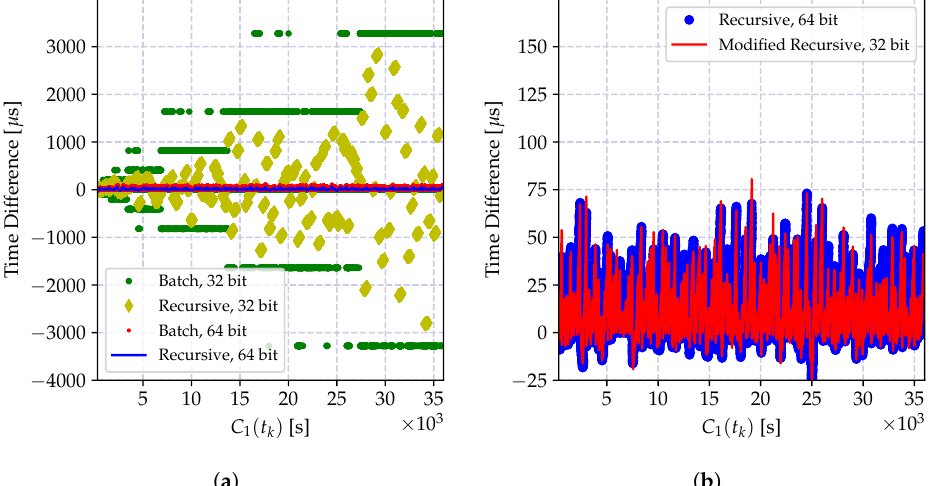
Figure 11. The variation of the time difference in microseconds between the time reports of a local clock and a reference clock with 32-bit and 64-bit floating point numerical precision representation of the quantities when the time relation parameters of the incremental time model are estimated every ∆ = 300 s. In ( a ), the performance of batch linear regression with a regression table of N = 8 entries, and recursive weighted maximum likelihood estimator with weight λ = 0.4. In ( b ), numerically stabilized estimator and 64-bit implementation of the recursive